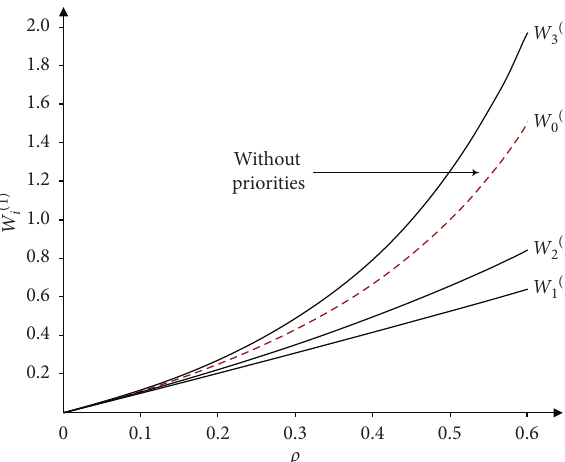
Figure 9: Mean values of waiting time for demands with different priorities.